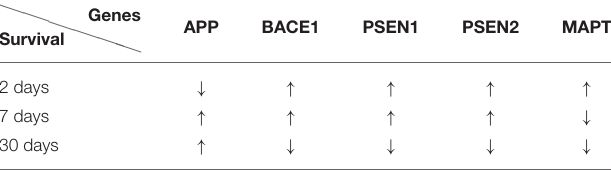
TABLE 1 | Changes in the expression of the Alzheimer’s disease-linked genes in the CA1 region of the hippocampus at various times after experimental ischemic brain injury.